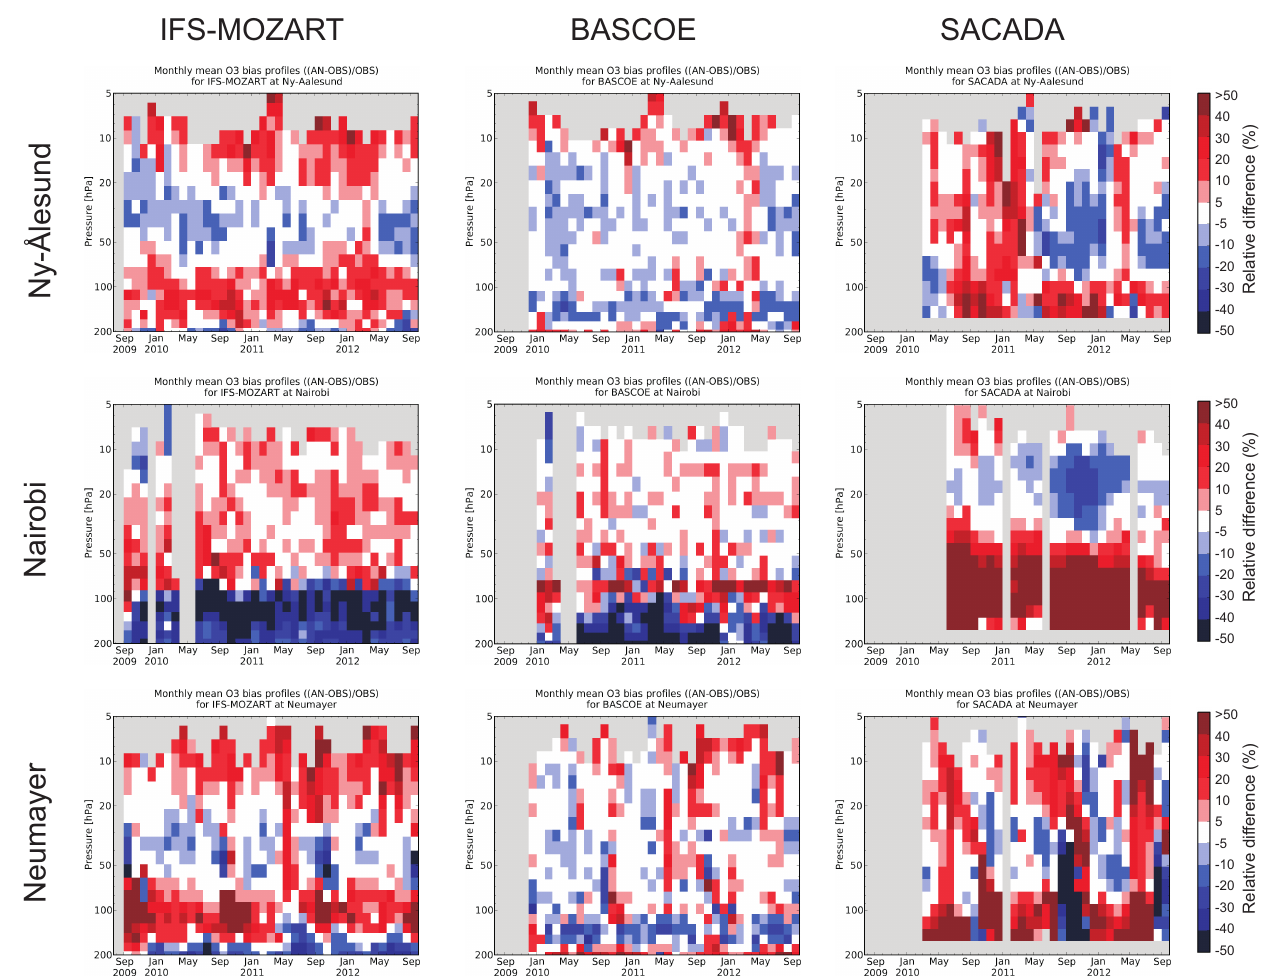
Figure 3. Time series of monthly mean ozone biases (analysis minus observations) with respect to ozonesondes at Ny-Ålesund (top panel, 78.92 ◦ N, 11.93 ◦ E), Nairobi (middle panel, 1.27 ◦ S, 36.8 ◦ E) and Neumayer (bottom panel, 70.68 ◦ S, 8.26 ◦ W) for the period September 2009 to September 2012 in %. Left: IFS-MOZART, middle: BASCOE, right: